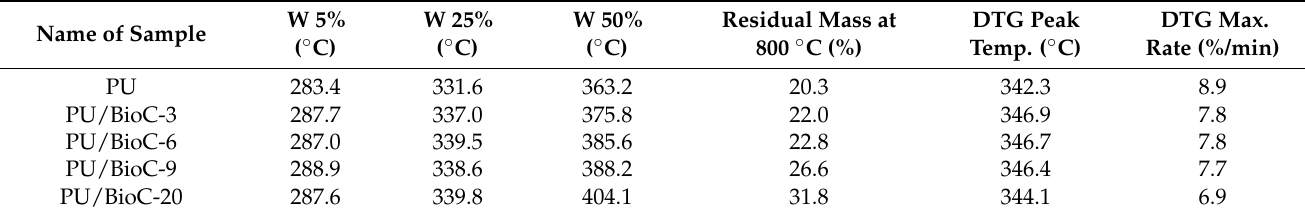
Table 5. Results of TG and DTG plots analysis.